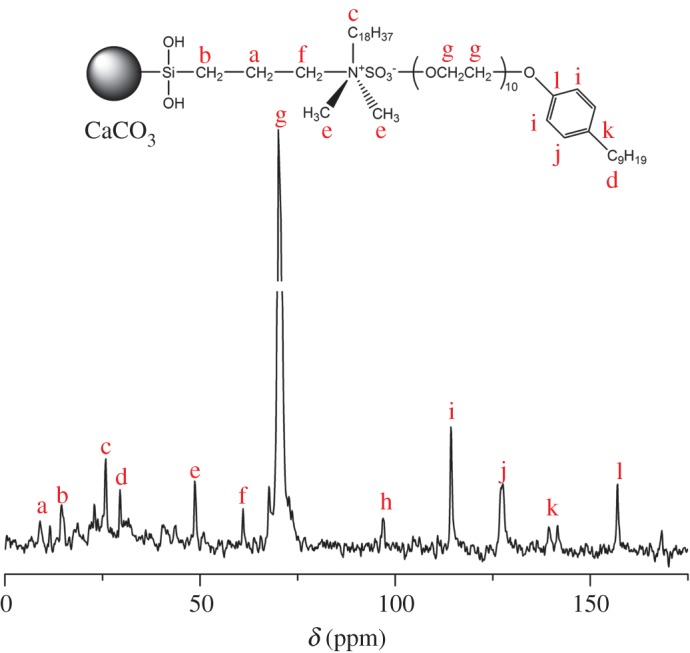
Solid-state 13C NMR spectrum of CaCO3-based NIMs.